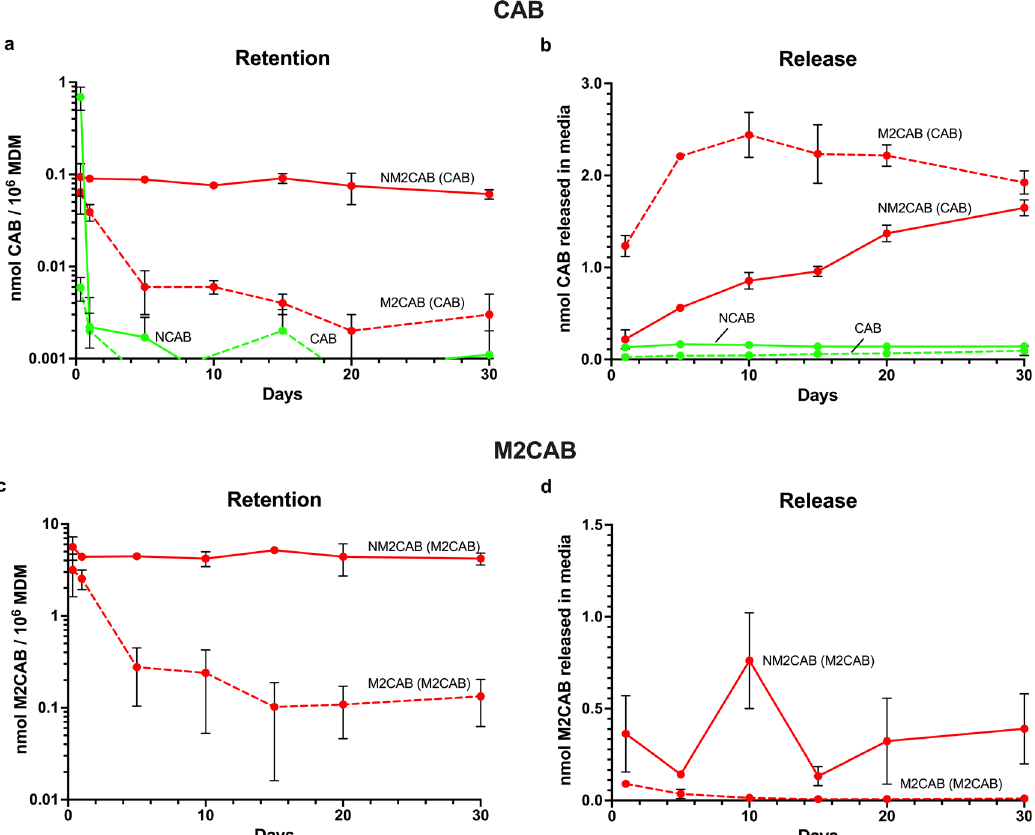
Fig. 4 Cellular uptake, retention, and release of native drug and prodrug. a Intracellular CAB, b CAB released in media; c intracellular M2CAB, and d M2CAB released in media after native-CAB, native-M2CAB, NCAB, and NM2CAB treatment to human monocyte-derived macrophages (MDM) at 10 µ M (10 nmol/10 6 cells) for 8 h. Data are expressed as mean ± SEM ( N = 3 cell culture wells per time point). Each experiment was repeated independently a minimum of three times with similar